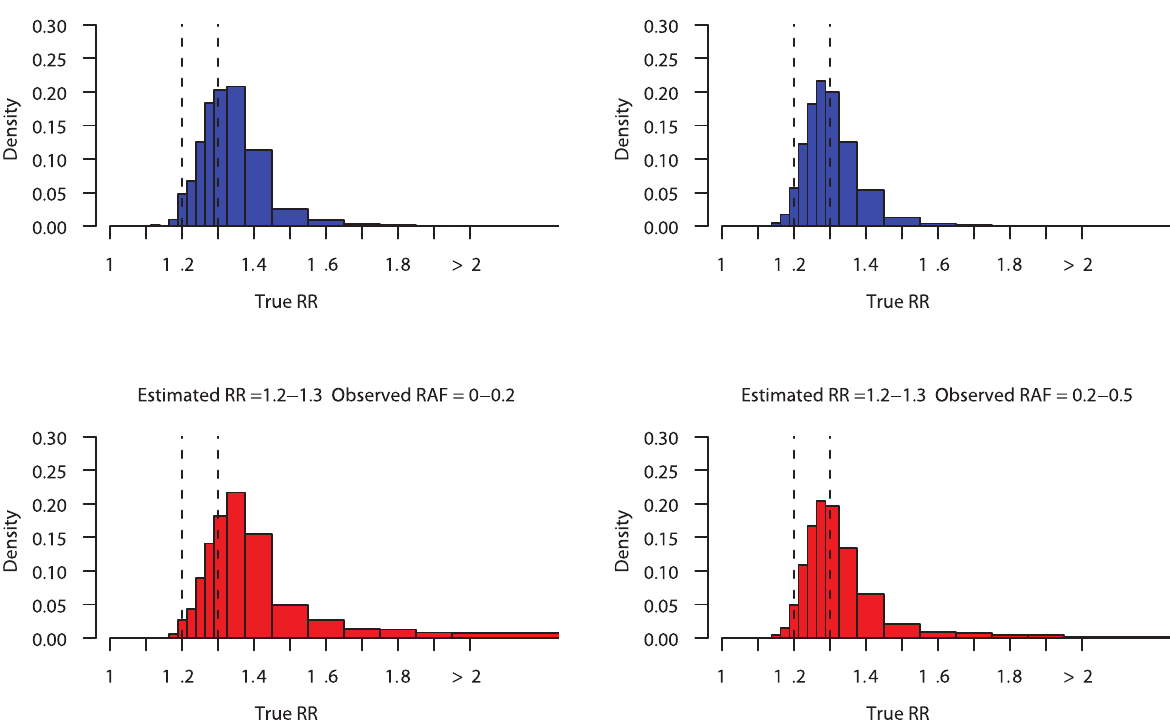
Figure 3. Posterior distribution on true relative risk. Histograms showing the posterior distribution on the true relative risk (RR) conditional on observing an estimated relative risk in the range 1.2–1.3 (vertical dashed lines). Left hand plots condition on the observed risk allele frequency (RAF) being between 20 and 50%, while the right hand plots condition on a RAF less than 20%. Results are shown using two different priors on RR and RAF: the blue histograms are the posterior distribution obtained using a conservative prior, and the red histograms are the posterior distribution obtained using the MAF-dependent prior.